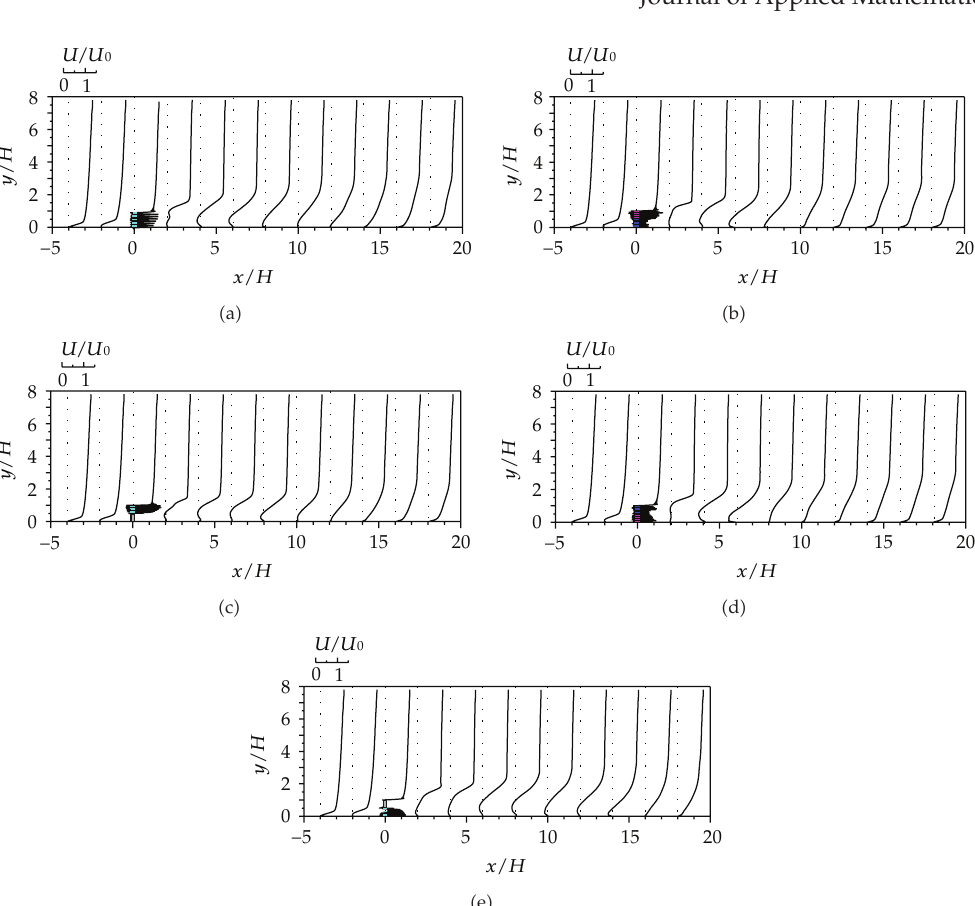
streamlines are shifted and there is a recirculation flow region behind the fence. When the porous fence is nonuniform, the bleed flow has a velocity gradient in the vertical